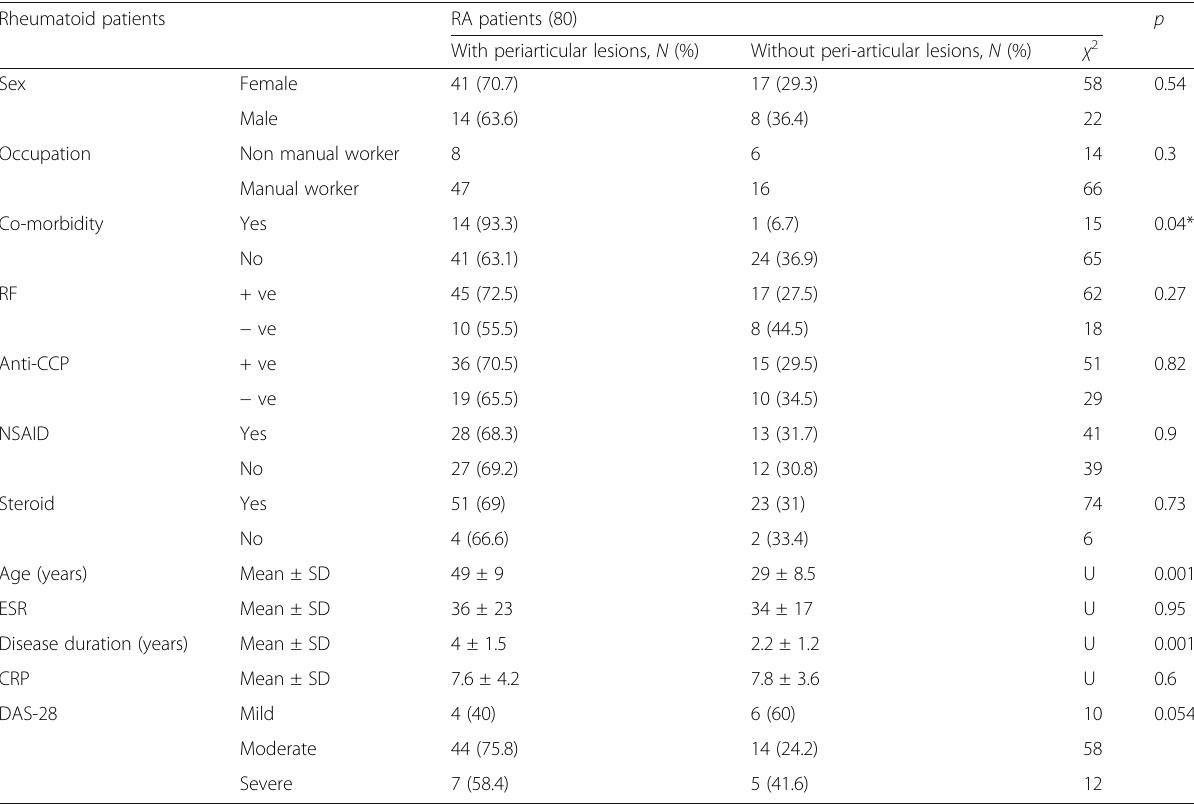
Table 3 Association between peri-articular subclinical ultrasound shoulder joint lesions in RA patients and their demographic, clinical and treatment parameters Rheumatoid patients